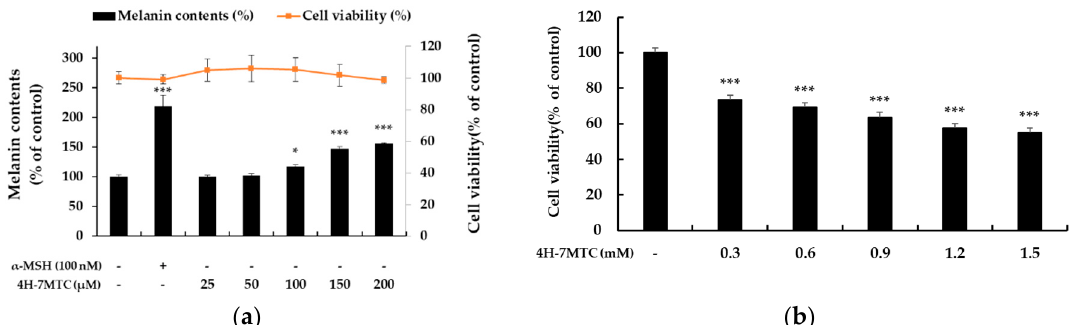
Figure 3. Effect of 4H-7MTC on the production of melanin ( a ) in α -MSH-stimulated B16F10 cells and Cytotoxicity of 4H-7MTC in B16F10 cells ( b ). Cells were plated in 60 mm cell culture dish (6.0 × 10 4 cells / dish), incubated for 24 h, and then treated with 4H-7MTC (25, 50, 100, 150 and 200 µ M) for 72 h in the presence of α -MSH (100 nM). α -MSH was used as the negative control. Cytotoxicity of 4H-7MTC was evaluated using MTT assay. Cells were plated in 24-well plates (1.5 × 10 4 cells / well) for 24 h, and then treated with 4H-7MTC (0.3, 0.6, 0.9, 1.2, and 1.5 mM) for 72 h. The data are presented as mean ± SD. Statistical significance was assessed by one-way analysis of variance (ANOVA) followed by Tukey’s post-hoc test and represented as follows: * p < 0.05, ** p < 0.01, *** p < 0.001 vs. LPS alone. To further elucidate the anti-inflammatory mechanisms of 4H-7MTC, we measured the levels of PGE 2 , IL-6, IL-1 β , and TNF- α in culture supernatants using ELISA. Treatment of RAW264.7 cells with LPS alone resulted in a significant increase in cytokine production compared to that in the drug groups (Figure 4). However, NO, PGE 2 , IL-6, IL-1 β , and TNF- α levels in the supernatants of LPS- stimulated cells pretreated with 0.3, 0.6, 0.9, and 1.2 mM 4H-7MTC were significantly reduced compared to those in the LPS group in a concentration-dependent manner (Figure 4).